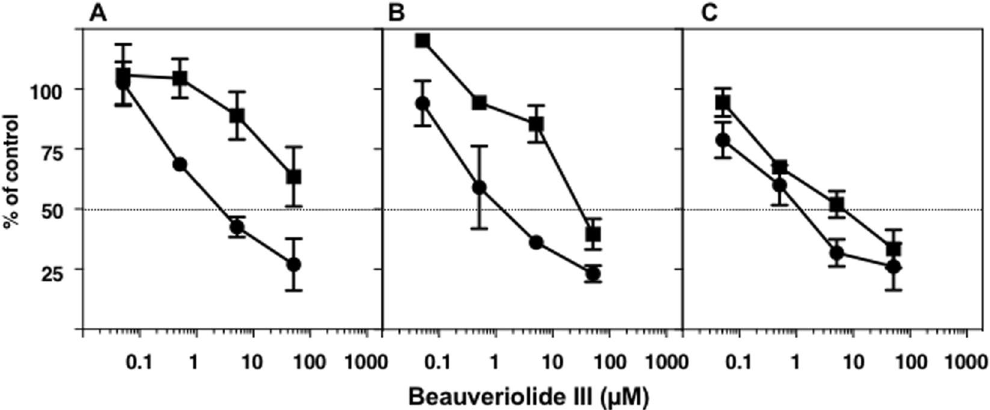
Fig. 4C, BeauIII inhibited the SOAT1 isozyme with an IC 50 of 0.71 µ M, and the SOAT2 isozyme with an IC 50 of 29